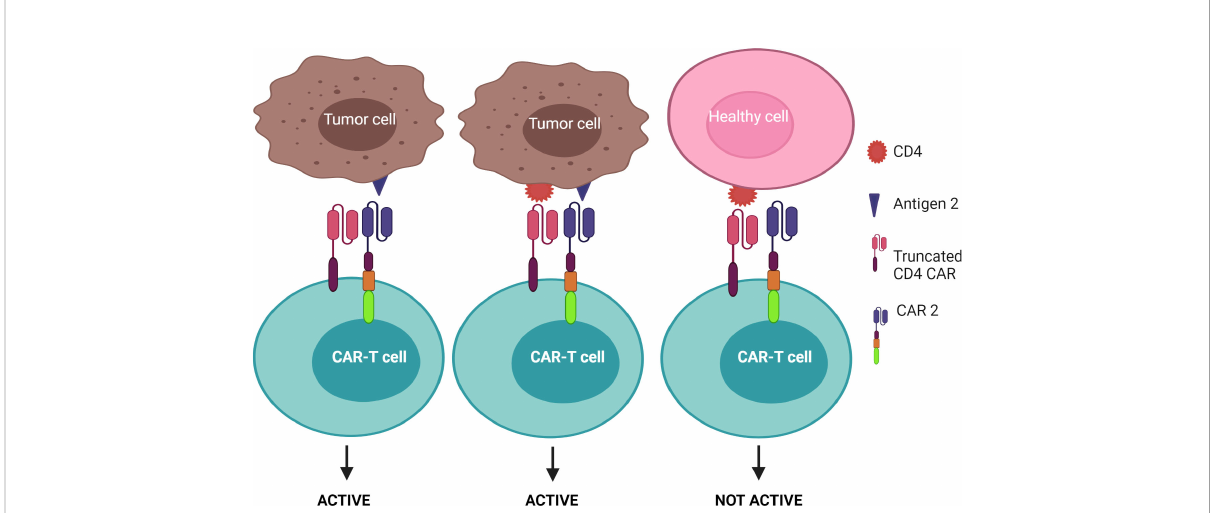
FIGURE 6 “ HELP ” logic-gated CAR-T cells for improving tumor recognition and alleviating on-target/off-tumor cytotoxicity on CD4 + healthy T cells. Truncated CD4 CAR directs CAR-T cells to CD4 + cells but does not trigger CAR-T cell activation without the presence of the second